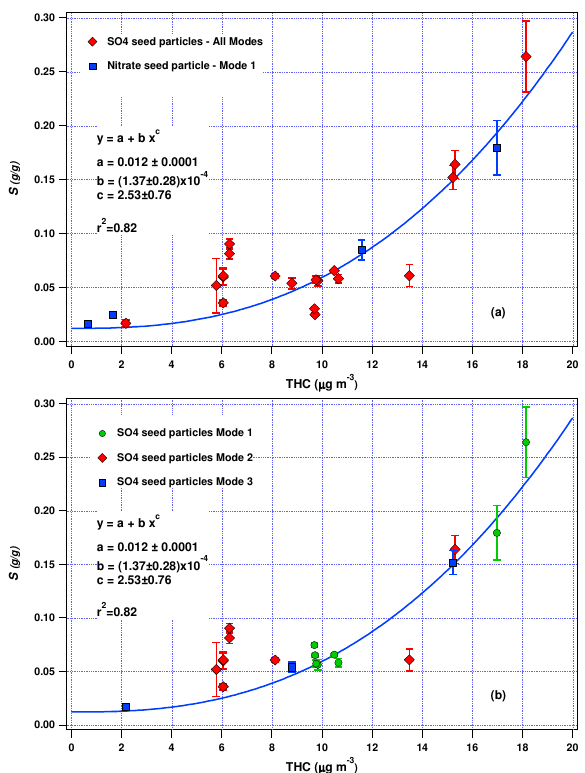
Figure 5. The amount of dissolution of organic mass in inorganic particles, S , in g/g unit versus the concentrations of THC in the gasoline engine exhaust, C THC . A non-linear increase in S is observed with increasing C THC . The relationship is fitted with a power function as shown by the fitted curve. The uncertainties in S are derived from the linear fits to COM versus seed particle mass. (a) Red diamonds are S for (NH 4 ) 2 SO 4 seed particles of all engine modes; blue squares are for NH 4 NO 3 seed particles in engine mode 1. (b) S for (NH 4 ) 2 SO 4 seed particles in engine modes 1, 2, and 3.